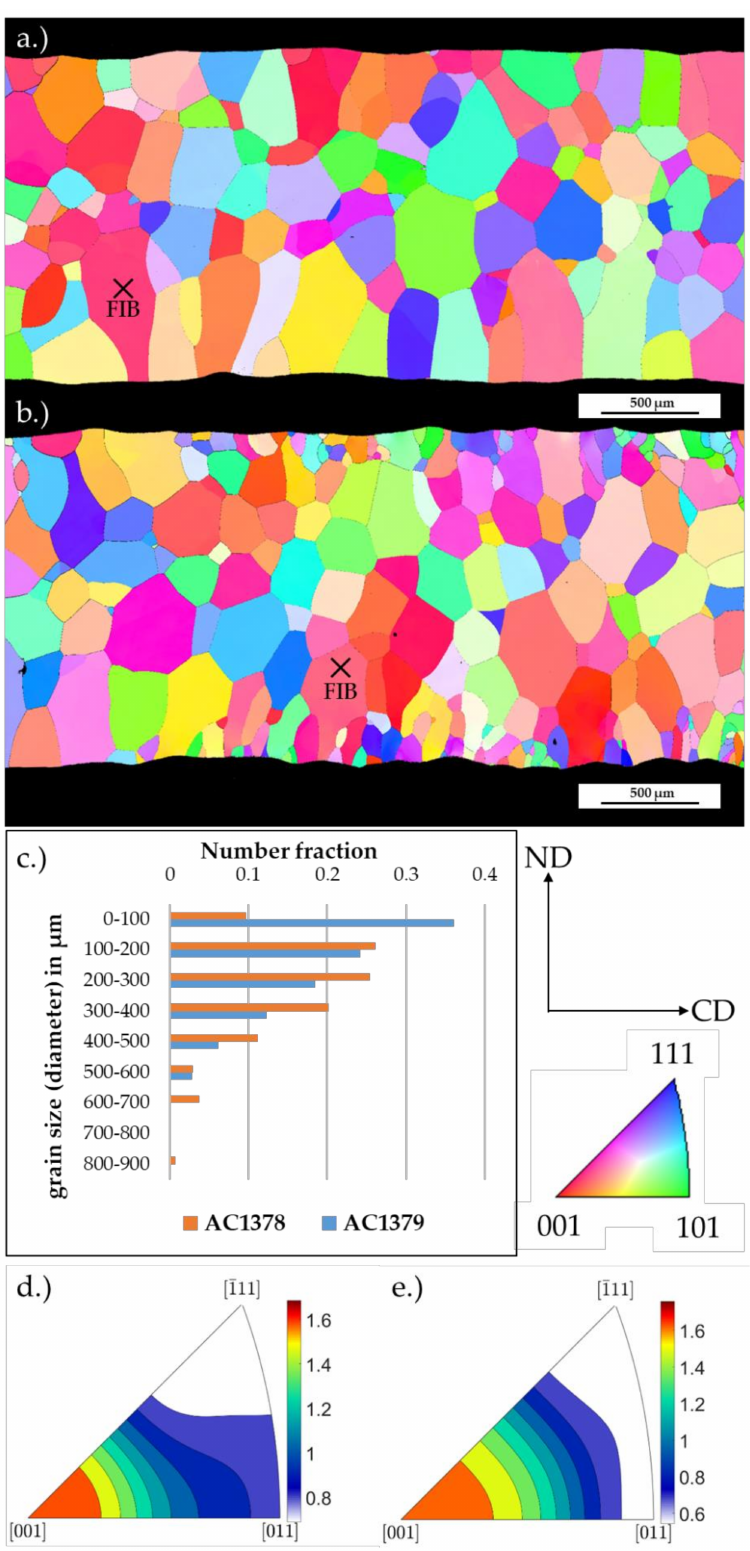
Figure 2. Results of the EBSD measurements represented as IPF-map. The color-coding refers to directions parallel to the normal direction (ND) of the sheet: ( a ) cast microstructure of AC1378 and ( b ) AC1379. The positions of the FIB-lamellae for TEM-measurements are marked with crosses. ( c ) illustrates the corresponding grain size (diameter) classes as histogram received from EBSD data. Calculated ODFs are presented as inverse pole figures referring to the normal direction of the sheet for ( d ) AC1378 and ( e ) AC1379. (Image source for ( a , b ): GfE RWTH